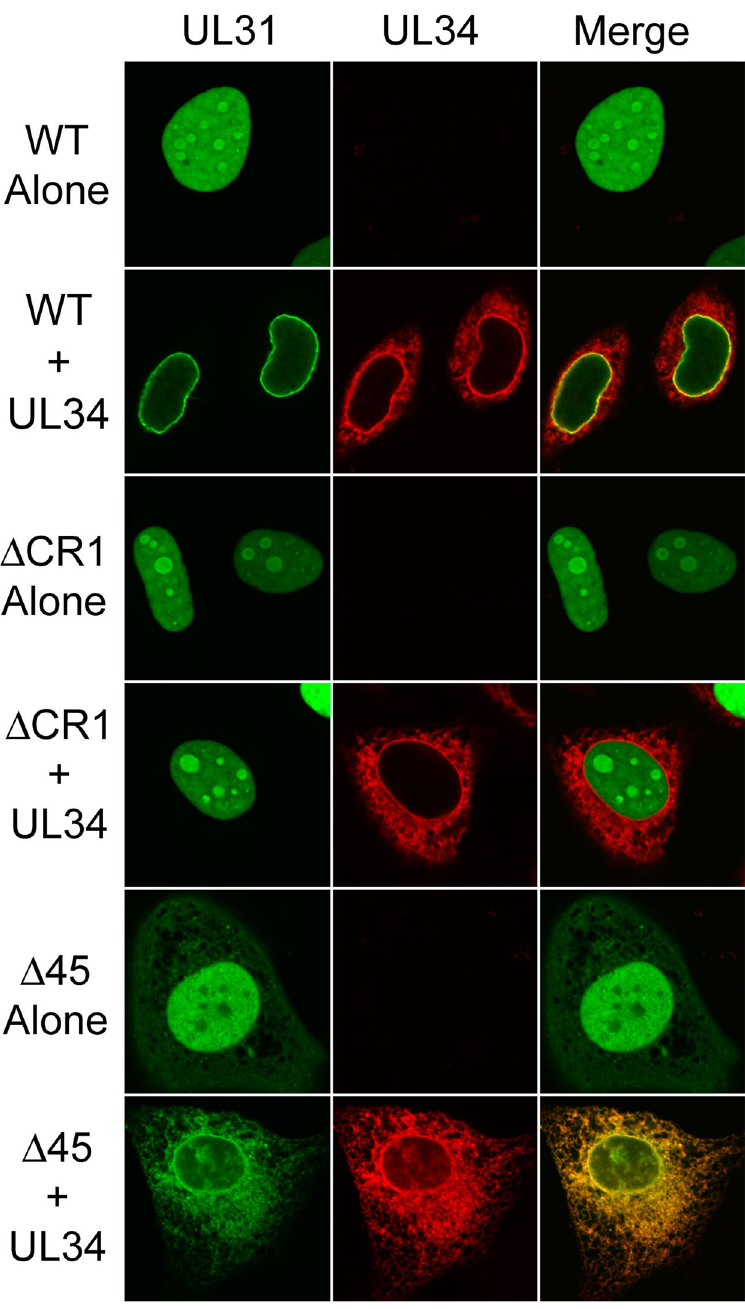
Figure 3. Recruitment of UL31 to sites of laser microirradiation is independent of its ability to interact with UL34. HeLa cells were transfected or co-transfected with plasmids encoding the EGFP-tagged WT, Δ CR1 or Δ 45 UL31 and, where indicated, FLAG-tagged UL34. At 16 h post transfection, cells were fixed and stained with anti-FLAG antibody and Alexa 568 conjugated secondary antibody (red signal). Representative images acquired by confocal microscopy are